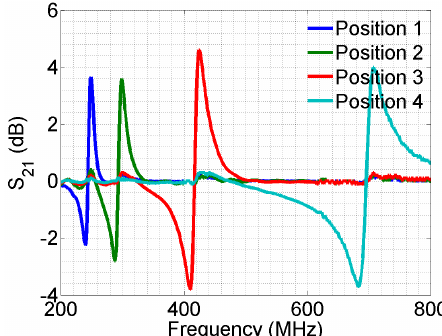
Figure 11. The transmission spectrum with the target at the four different positions, normalized by the unloaded